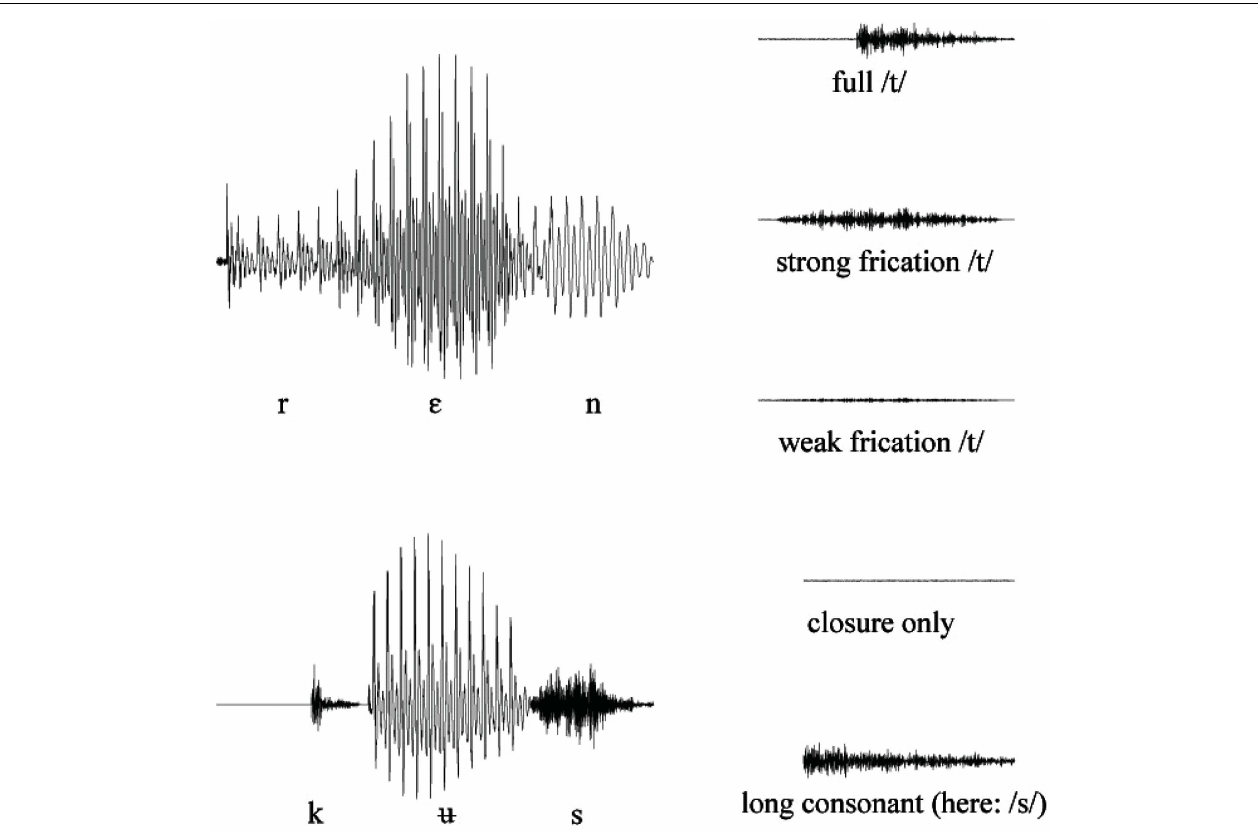
FIGURE 2 | Realizations of word-final /t/ in four Dutch casual speech utterances from full production (top row) to deletion (bottom row). See text for details.